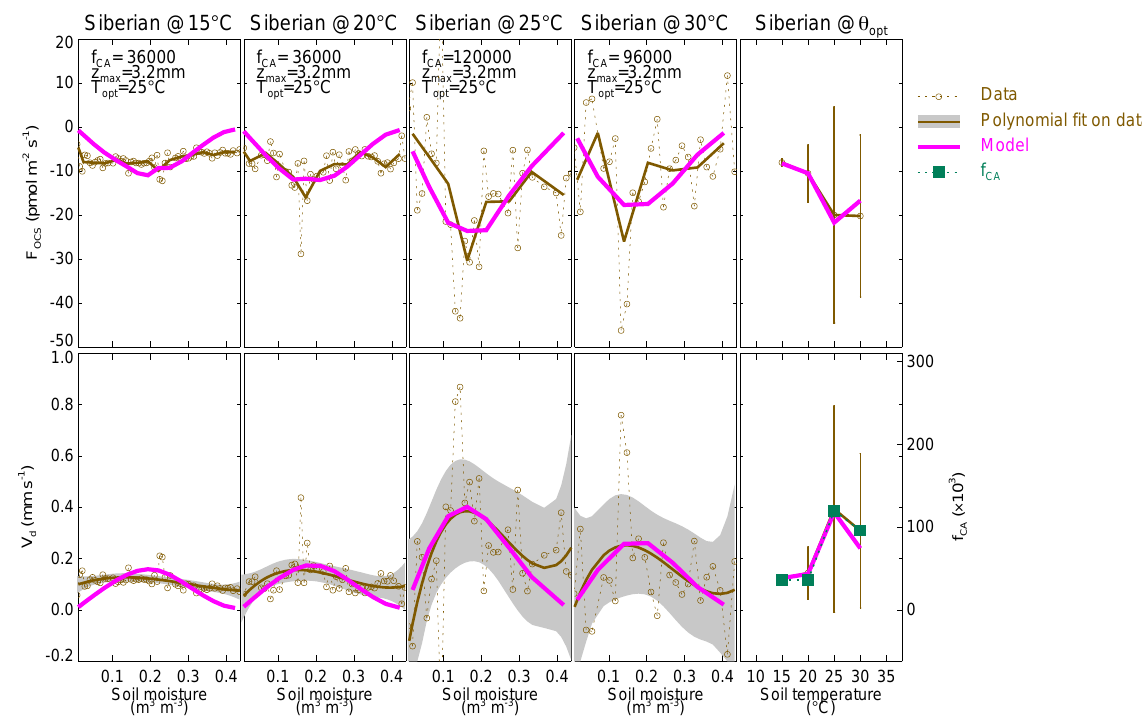
Figure 12. Same as Fig. 9 but for an agricultural soil from Siberia (soil weight is